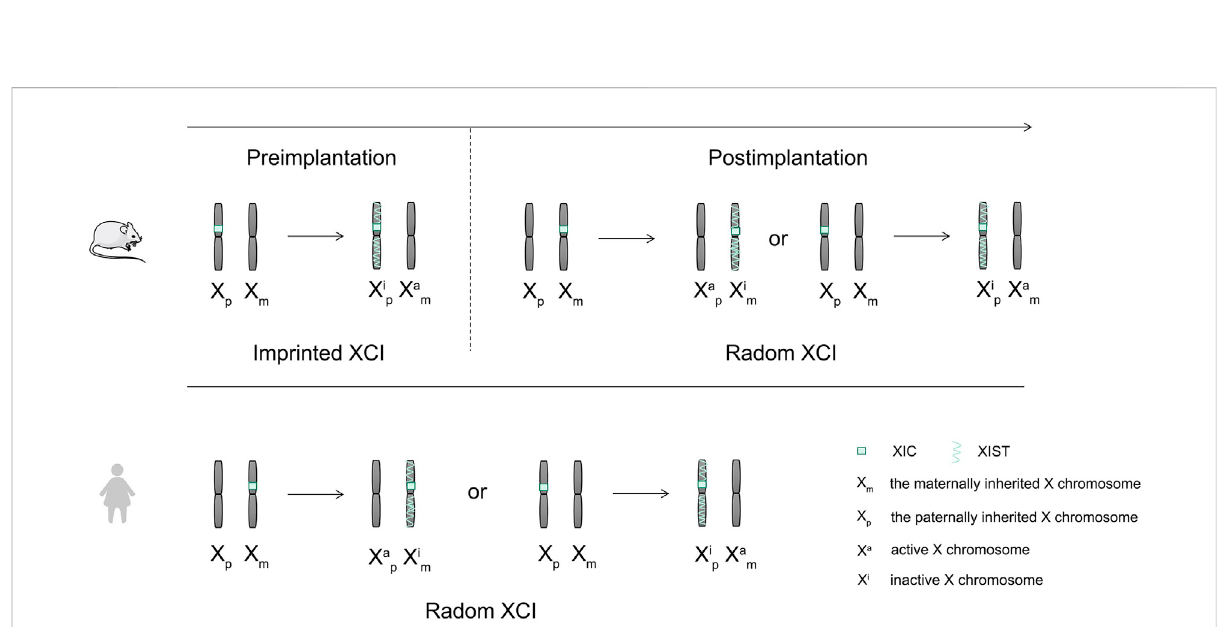
FIGURE 4 Mechanisms of X chromosome inactivation in mice and